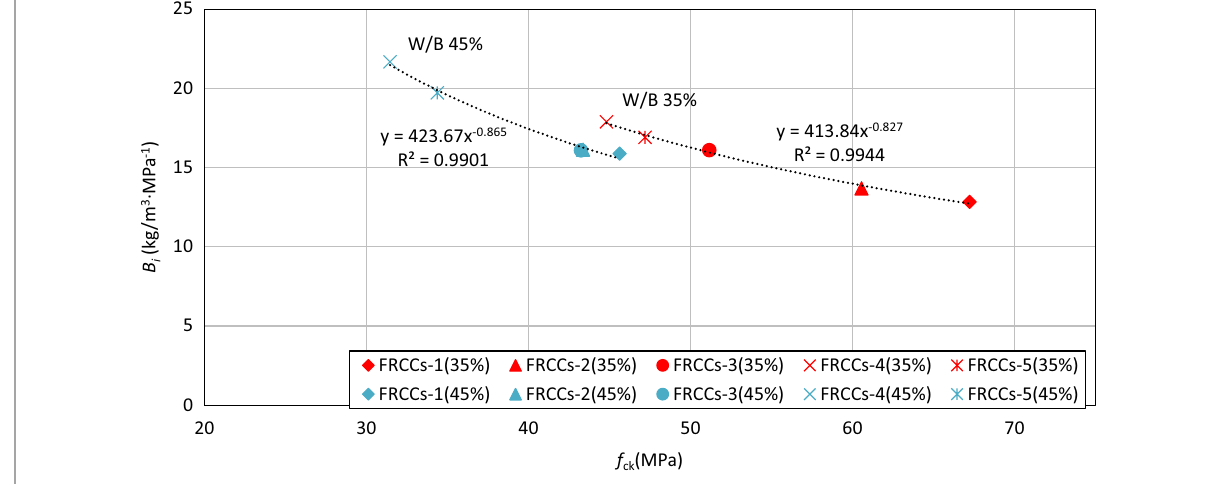
Fig. 4 Relationship between B i and f ck .